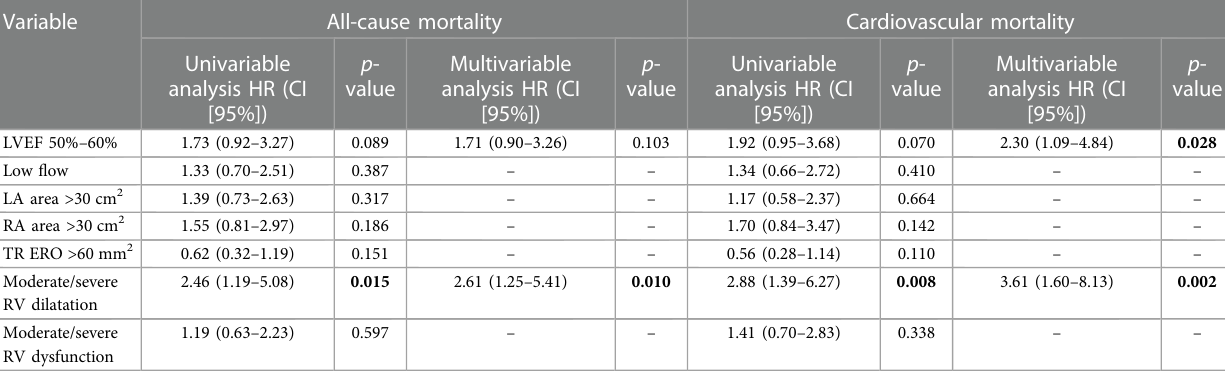
TABLE 4 Echocardiographic factors associated with all cause and cardiovascular mortality in patients with a tricuspid coaptation gap ≥ 10 mm.